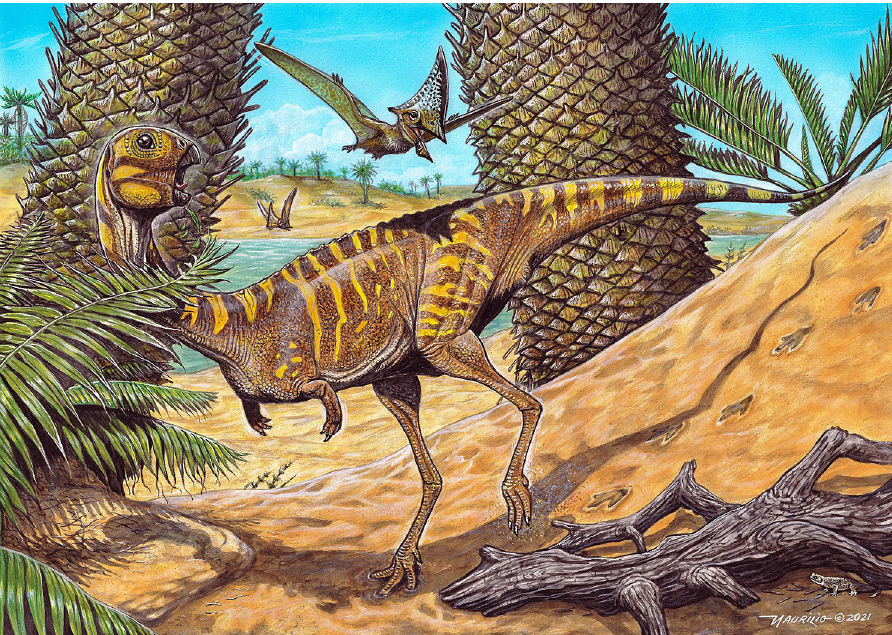
Figure 7. Life reconstruction of Berthasaura leopoldinae gen. et sp. nov . in the paleoenvironment represented by the “Cemitério dos Pterossauros”